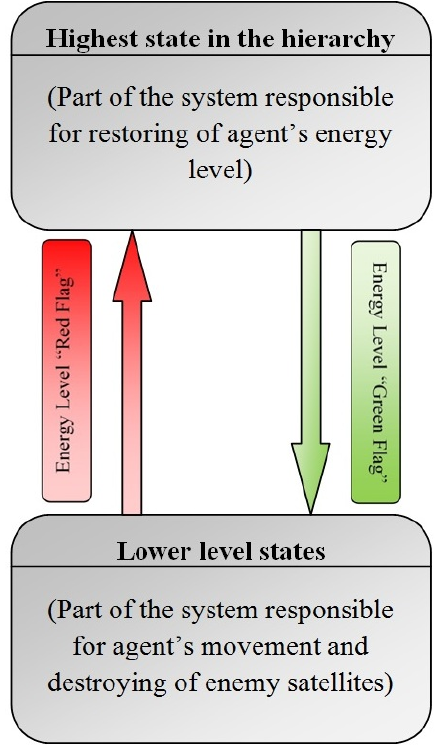
Figure 5. UML-like presentation of the hierarchy in the agent’s control system.